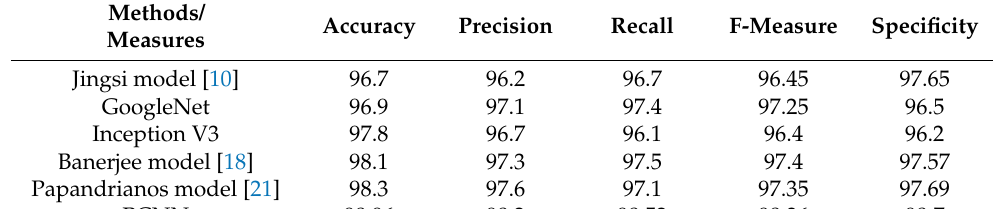
Table 7. Comparative analysis outcome of CNN model for dataset_1.